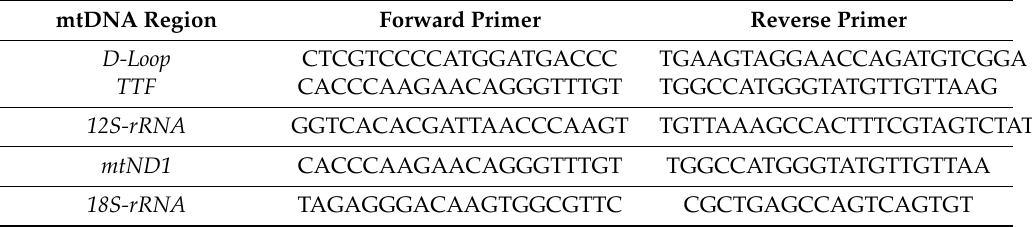
Table 1. Primer sequences for methylation